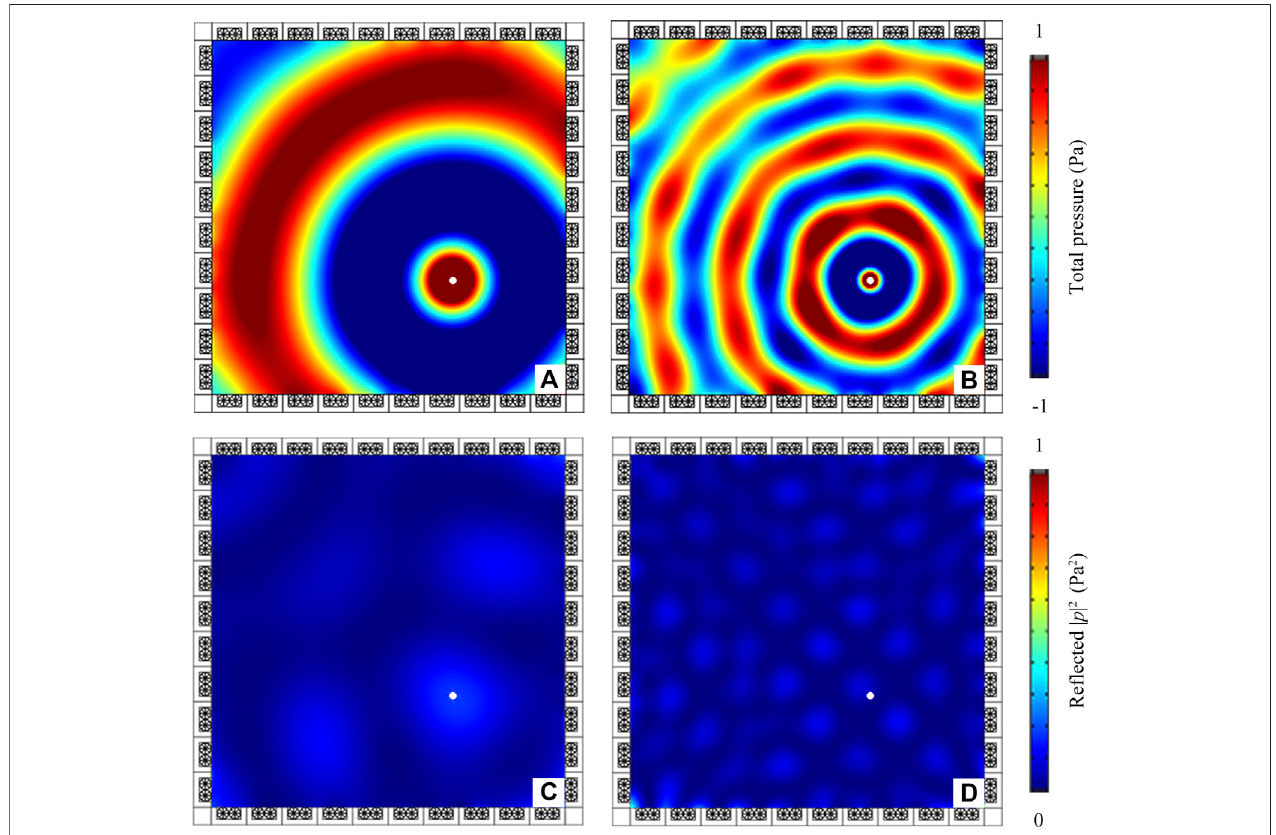
FIGURE 7 | Simulated total pressure distributions created by the barrier-free anechoic room at (A) 171 Hz and (B) 519 Hz, and their corresponding re fl ected intensity distributions at (C) 171 Hz and (D) 519 Hz. White points represent the positions of cylindrical sound source.